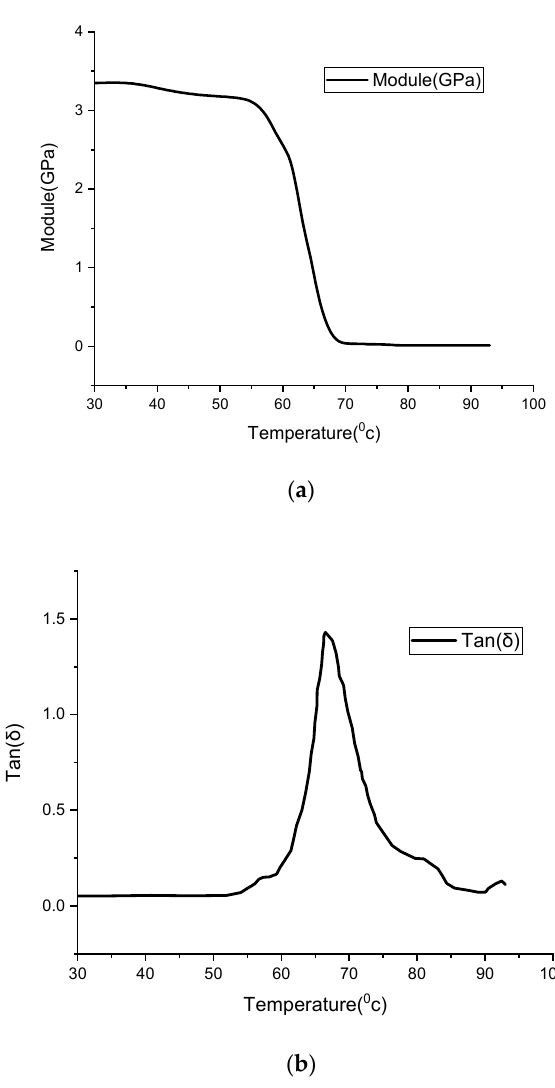
Figure 5. Dynamic mechanical analysis (DMA) results for polylactic acid (PLA): ( a ) Storage modulus 𝐸 (cid:4593) , ( b ) tan( δ ).